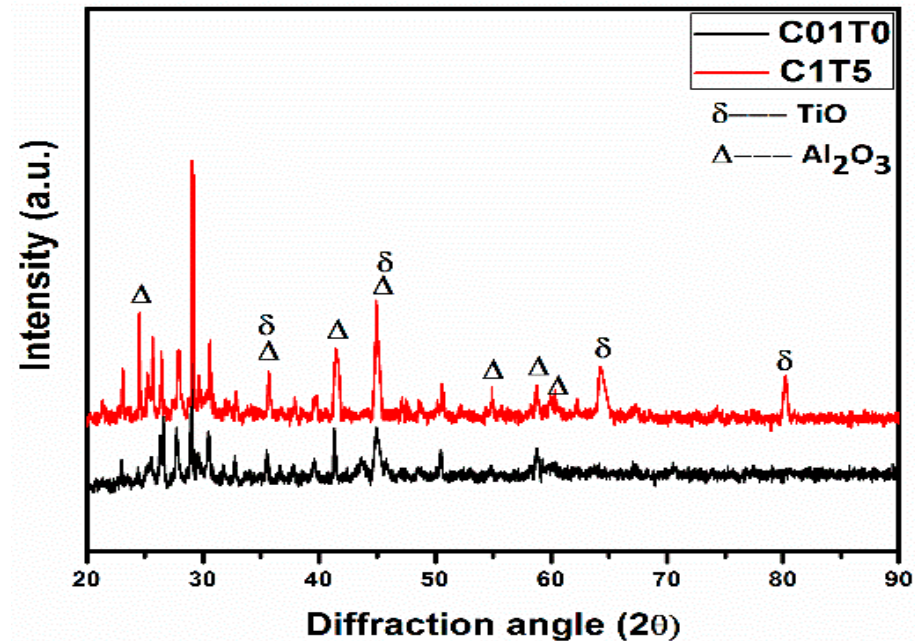
Figure 4. Comparative study showing the weight gain of ( a ) C01T0 and ( b ) C1T5 at different temperatures (Lines joining the data points are for visual aid only).